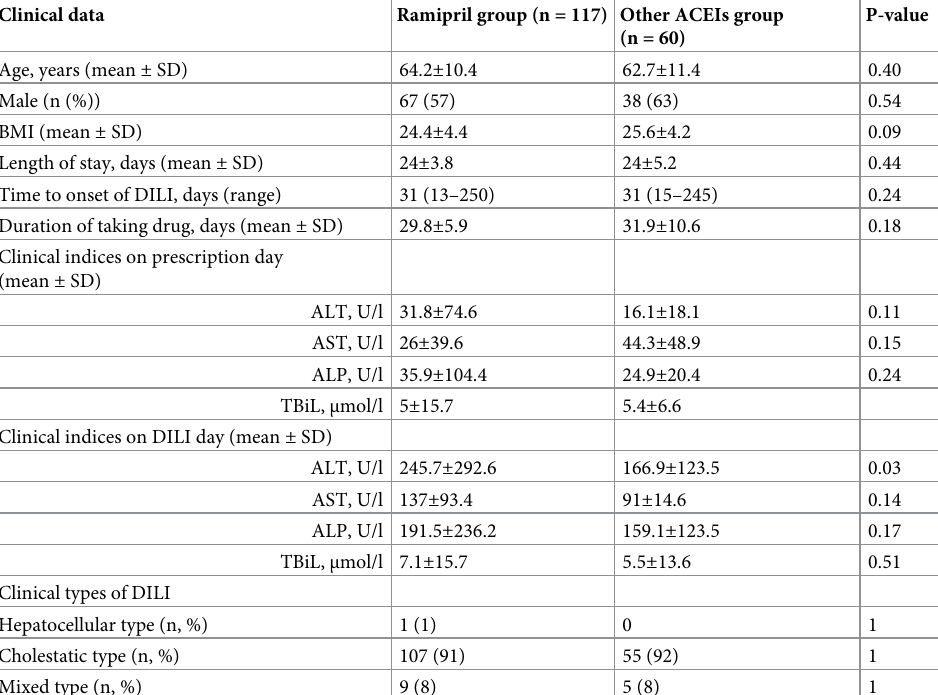
respectively. The group of patients stayed in the hospital for a long period, with an average time of 24 days in both groups. The duration of ramipril use in the ramipril group was similar to that of other ACEIs. On the day of prescription medication causing DILI, the ALT test results of the ramipril group revealed an average value of 31.8 ± 74.6 UI/L, which was similar to that in the group treated with other ACEIs (16.1 ± 18.1 UI/L; p = 0.11). Similar to the ALP results, the group that used ramipril with an average of 35.9 ± 104.4, this result was not different from the group without ramipril with p = 0.24. However, on the day DILI was diagnosed, the ramipril group had a 14.1-fold increase in ALP from 35.9 ± 104.4 (UI/L) to 191.5 ± 236.2. In the group using other ACEIs, this rate increased by approximately 11.3 times from 24.9 ± 20.4 (UI/ Table 3. Comparison of clinical characteristics of drug-induced liver injury patients taking ramipril (n = 117) or other angiotensin-converting enzyme inhibitors (n = 60). Clinical data